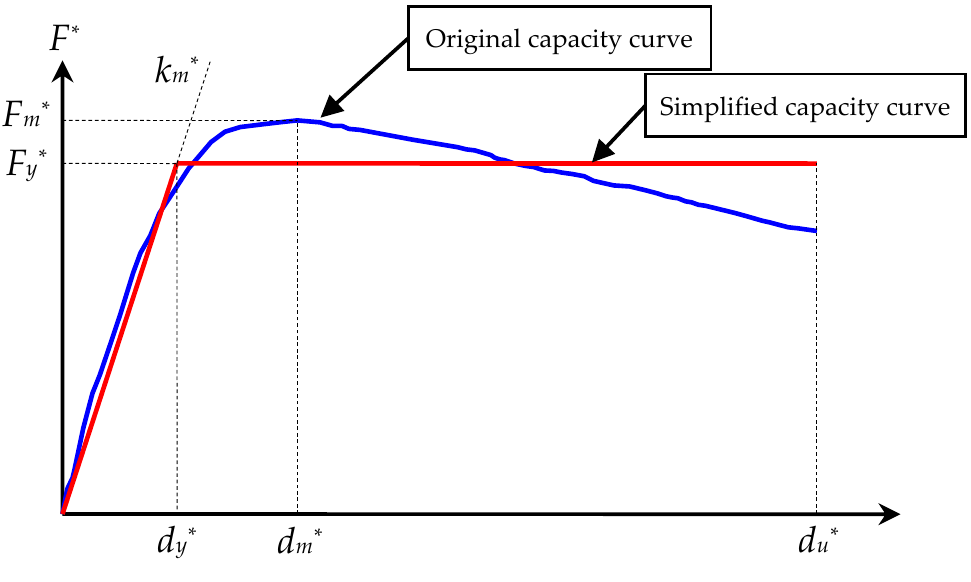
Figure 1. Original and simplified adopted capacity curve.